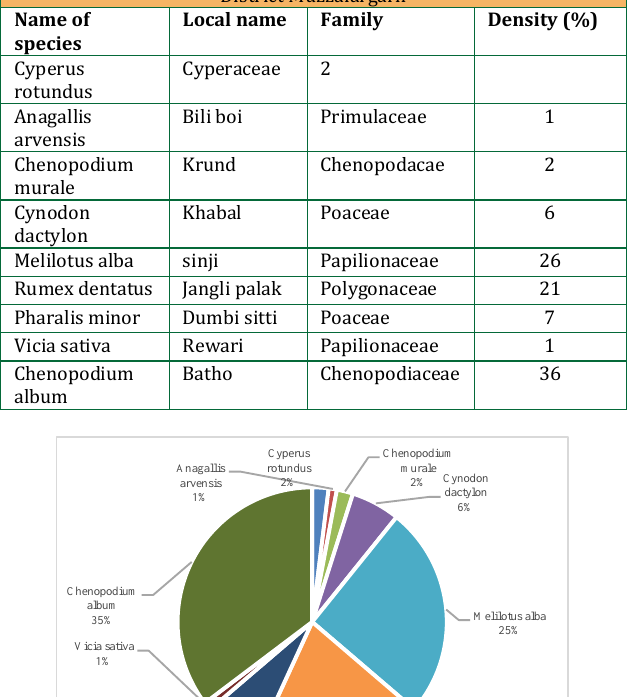
Figure 9: Frequency of weed infesting of wheat field district kot Addu district Muzaffargarh. Table 10: Density of weeds infesting wheat field at Kot Addu site District Muzzafargarh